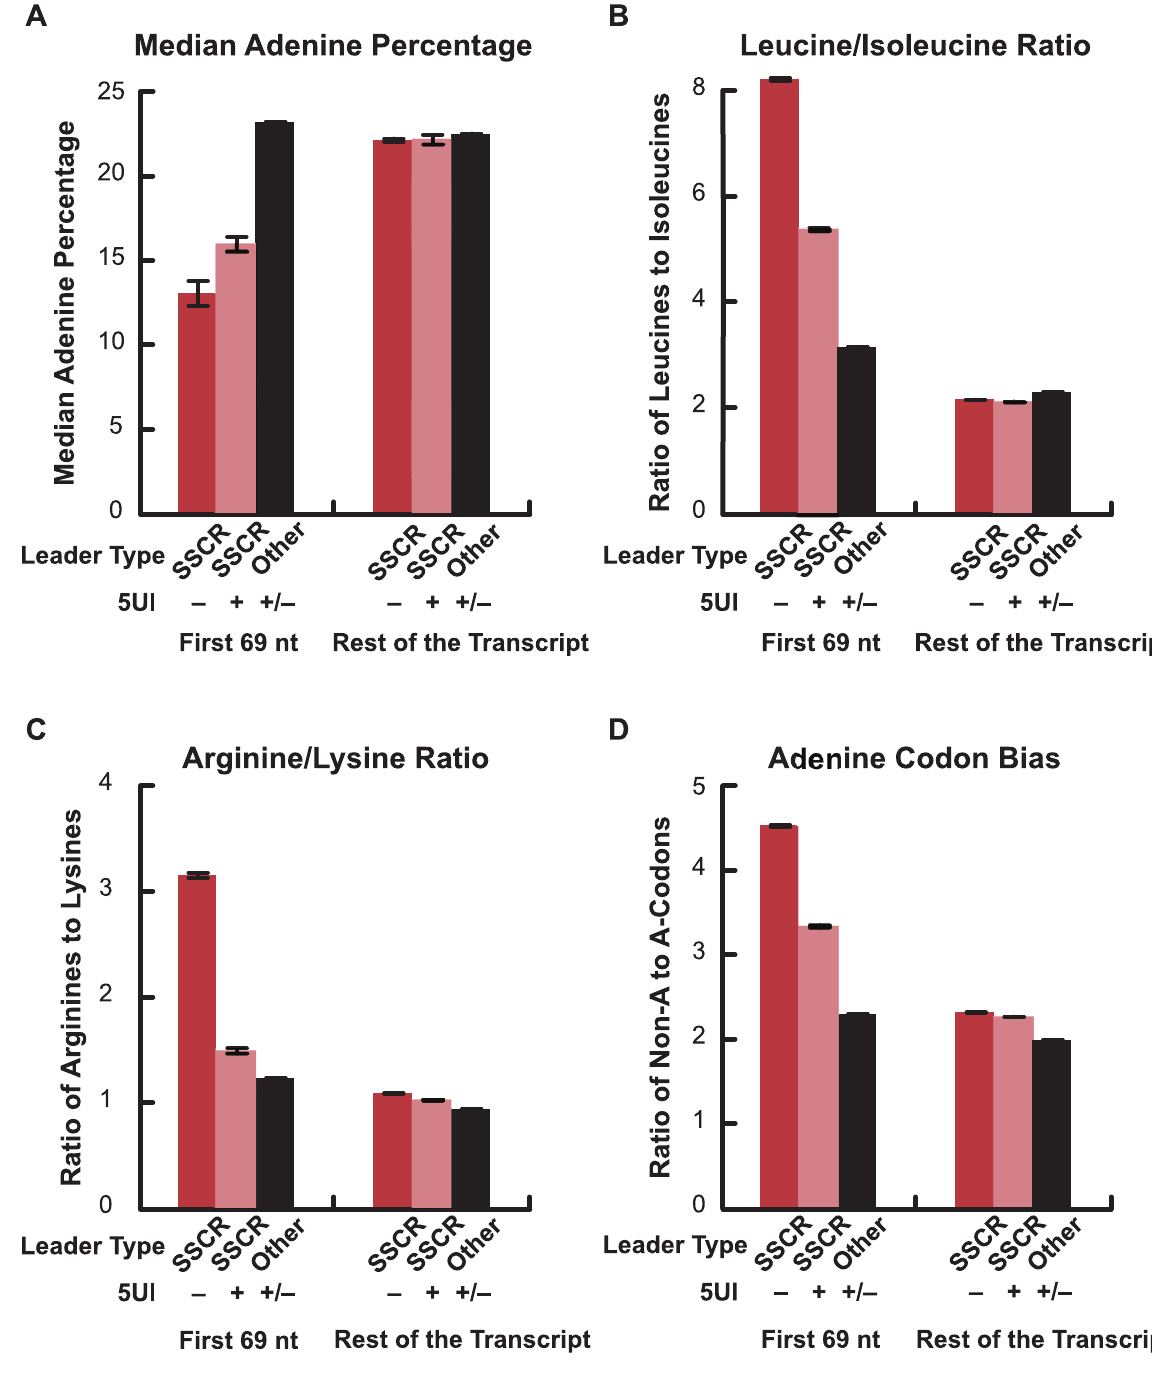
Figure 2. Adenine depletion in SSCRs is attenuated by 5UIs. All bars represent the average from the first 69 nucleotides of all SSCRs- containing open reading frames from the human genome which either lacked (‘‘ 2 ‘‘) or had (‘‘ + ’’) 5UIs. As controls, these sequences were compared to the rest of the open reading frame, or analogous regions from open reading frames that lacked SSCRs (‘‘other’’). Error bars correspond to standard errors of the median or mean, as appropriate. (A) Median adenine percentage. Standard error of the median was determined by bootstrap- resampling. (B) The mean ratio between the number of encoded leucines to isoleucines. (C) The mean ratio between the number of encoded arginines to lysines. (D) The ratio of adenine- lacking, to adenine-containing codons for all amino acids that have both types of codons (L, V, A, P, S, G, and R). See Figure S3 for examples of adenine codon bias for specific amino acids (leucine and serine).